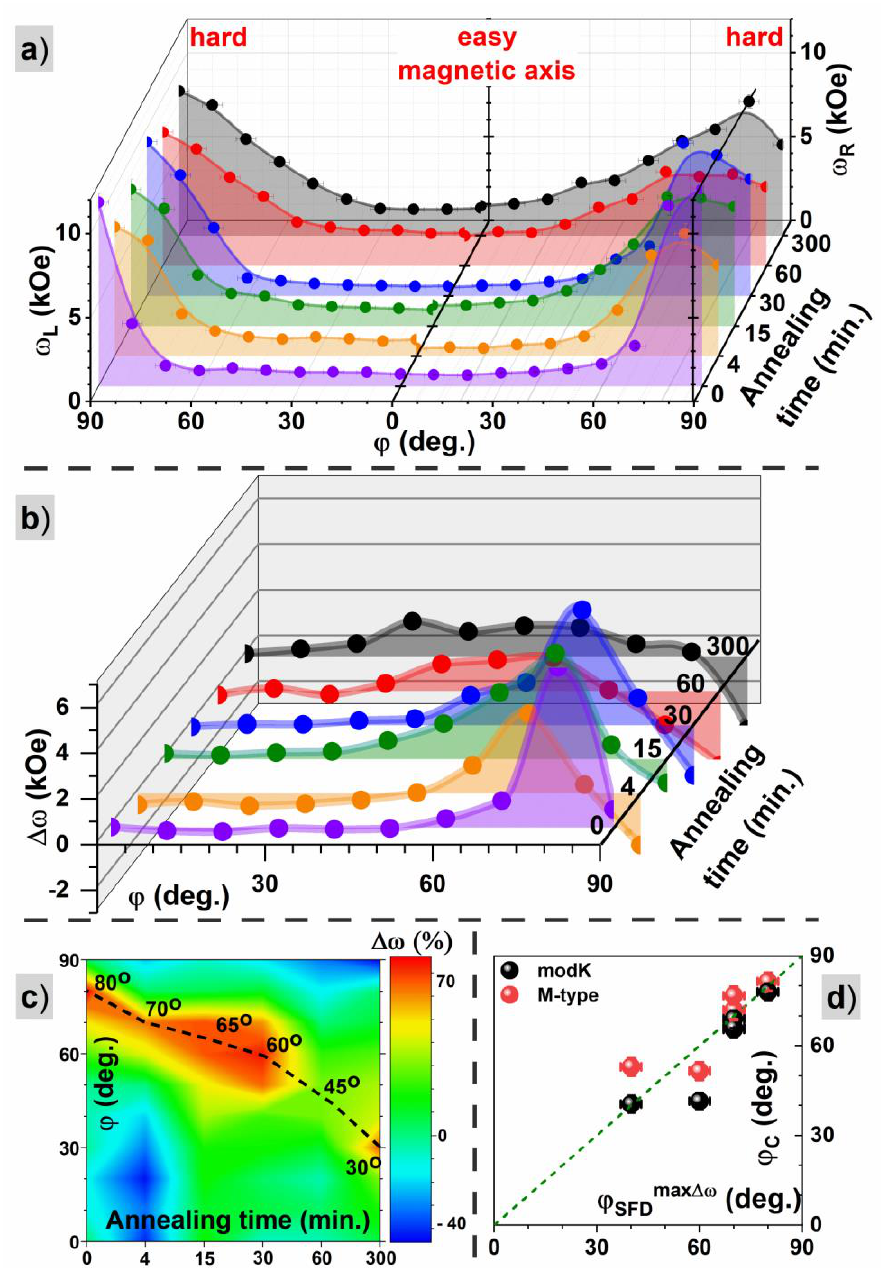
Figure 9. ( a ) Switching field distribution for samples treated with different times of annealing. The ω L and ω R are the widths of the left and right sides of the switching field distribution. ( b ) Difference ∆ ω between the right ω R and left ω L width of the switching field distribution at different stages of annealing. ( c ) Map of ∆ ω data with colors corresponding to the renormalized ∆ ω value. The dashed line marks angles where the maximum of the ∆ ω is observed. ( d ) Correlation of the critical angle of the reversal mechanism and the angle of maximal asymmetry in the SFD. The colors on ( a , b ) refer to samples annealed for different times.